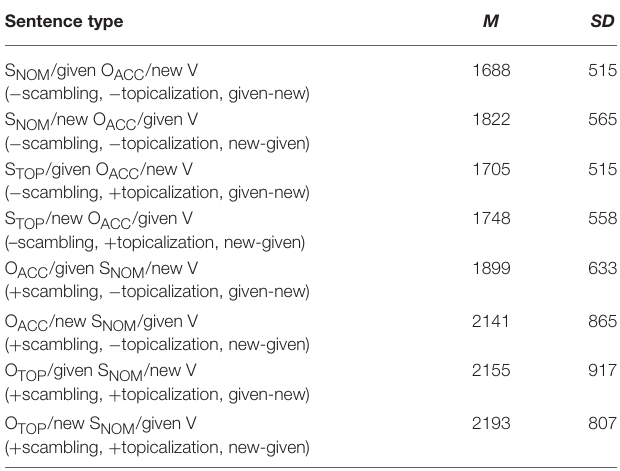
TABLE 4 | Reaction times (ms) for target